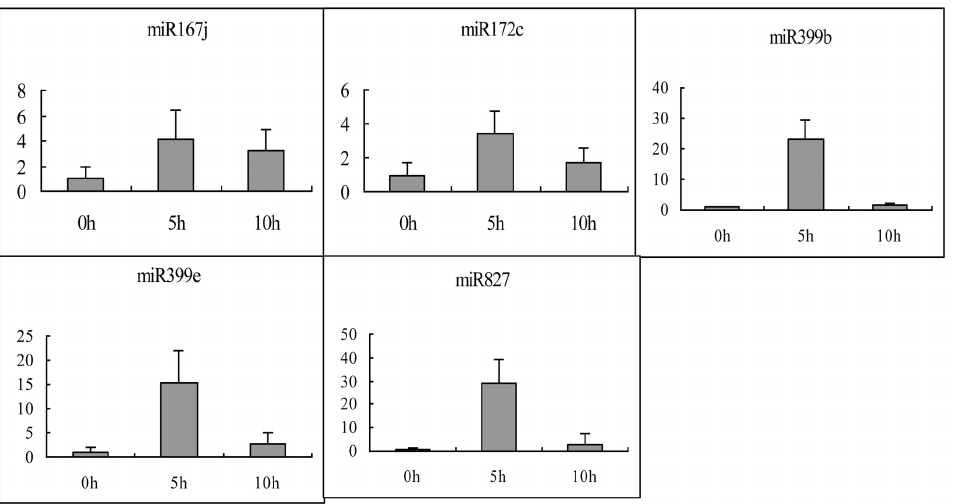
Figure 2. Quantitative analysis of the precursor levels of 5 miRNAs in the leaves using RT-qPCR at 0, 5 and 10 h. GAPDH RNA was used as the internal control. Error bars indicate SD obtained from three biological repeats.